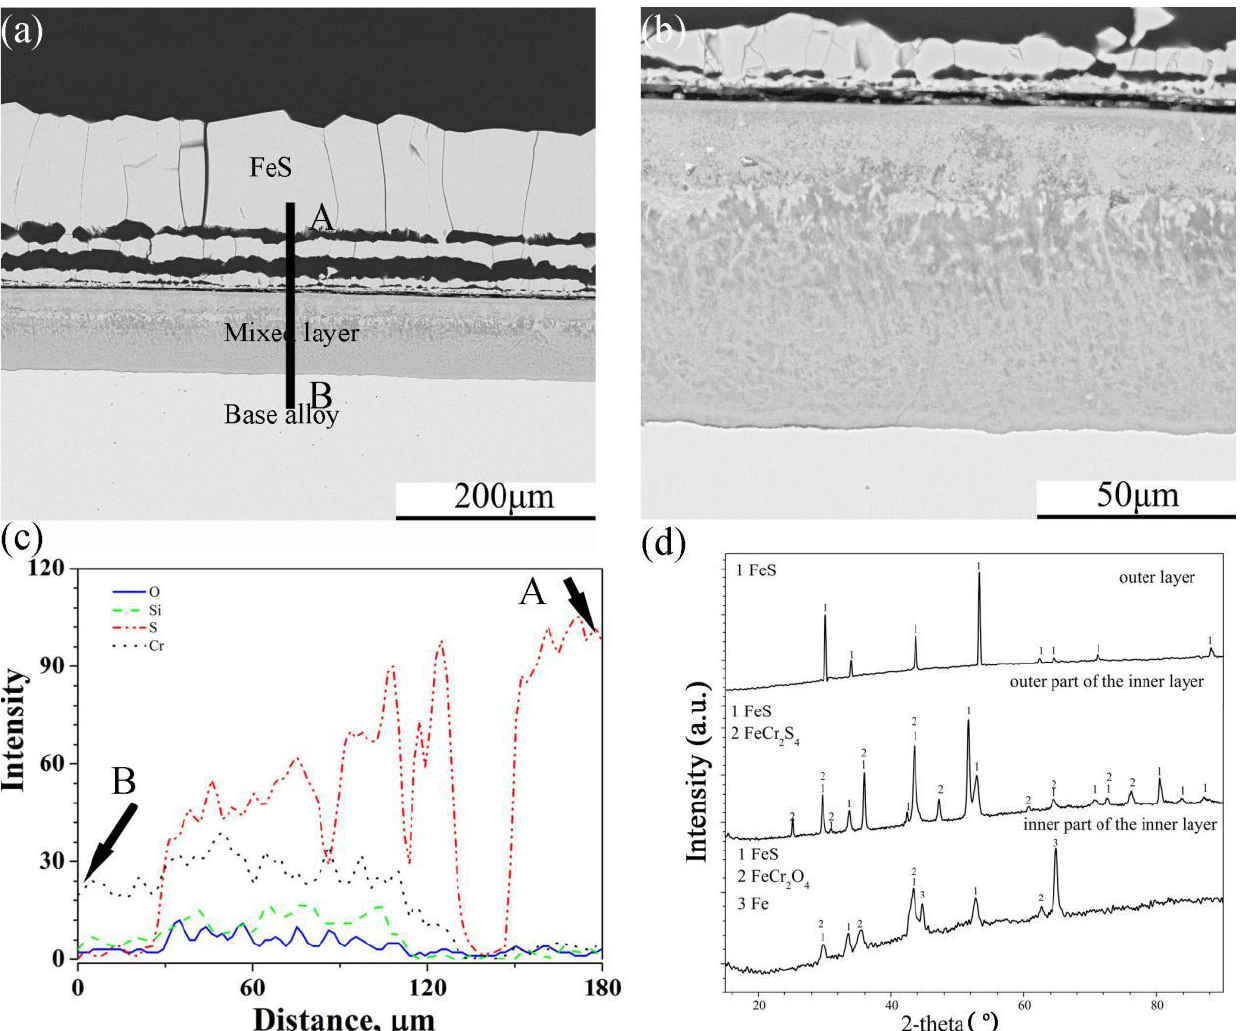
Figure 7. Cross-sectional image: ( a ) low-magnification, ( b ) high-magnification, ( c ) element depth profile analysed by EDS, where the scanning line AB corresponds to the line AB in ( a ) and XRD spectrum ( d ) of Fe-10Cr-5Si alloy corroded in H 2 -CO 2 -H 2 S mixture at 600 °C for 24 h.